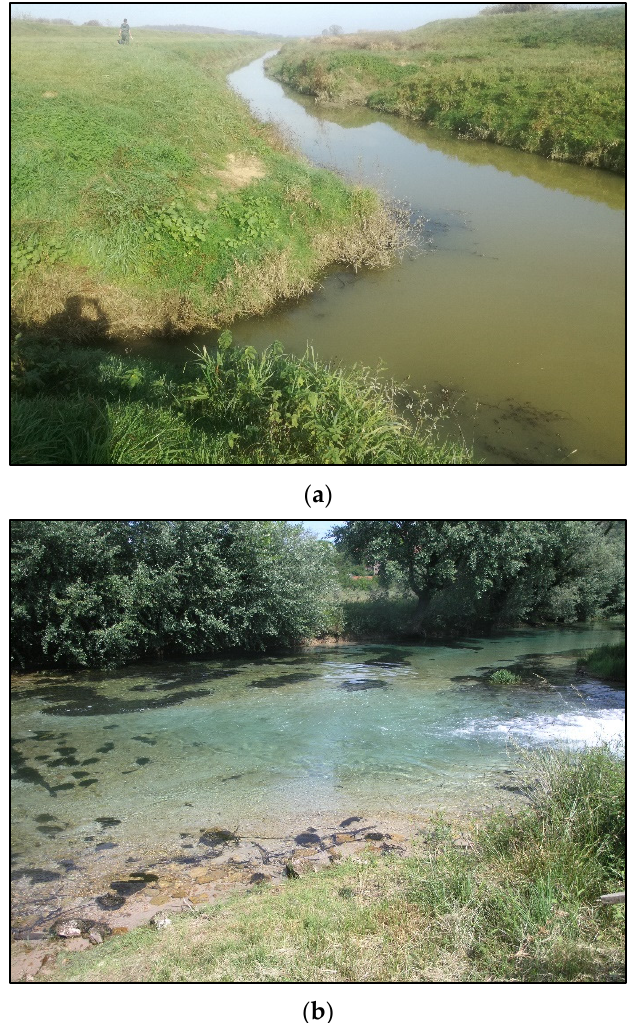
Figure 6. Sampling reference station at studied rivers: ( a ) high amount of suspended matter as one of the noticeable features of the Ilova River regardless of the season. ( b ) Clear karstic water of the Krka River in its upper course. Coarseness of the sediment was visible even from the position the photograph was taken from.